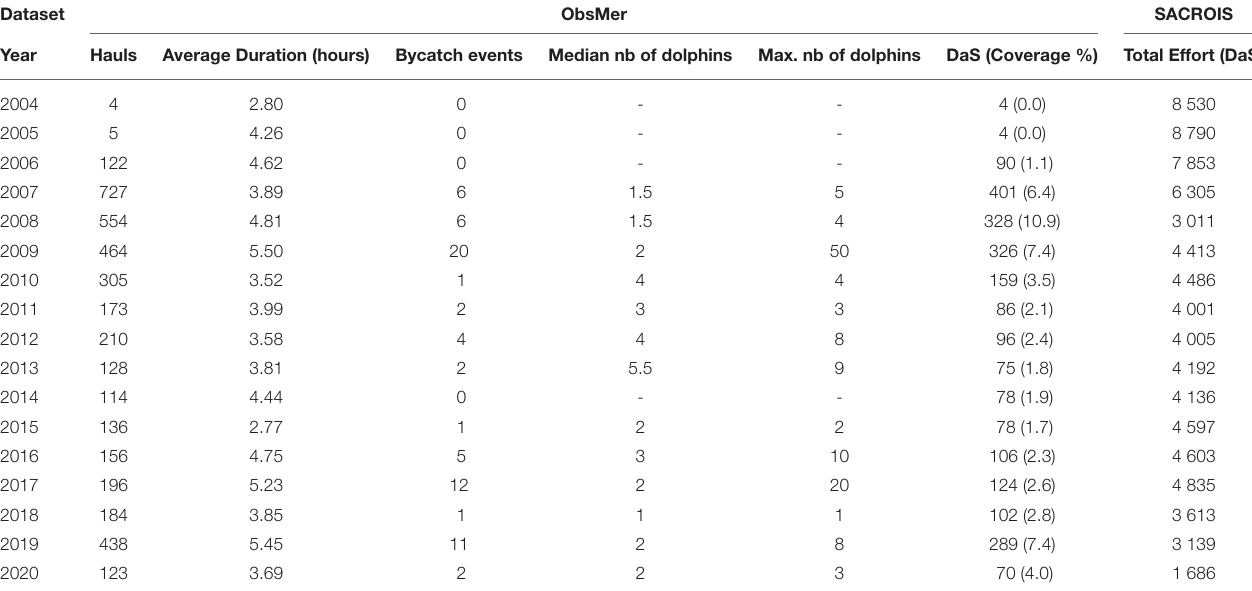
TABLE 2 | Descriptive statistics for Observation des captures en Mer (ObsMer) and SACROIS data displayed for each year.